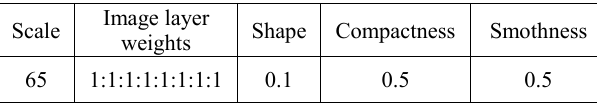
Table 2. The parameters of